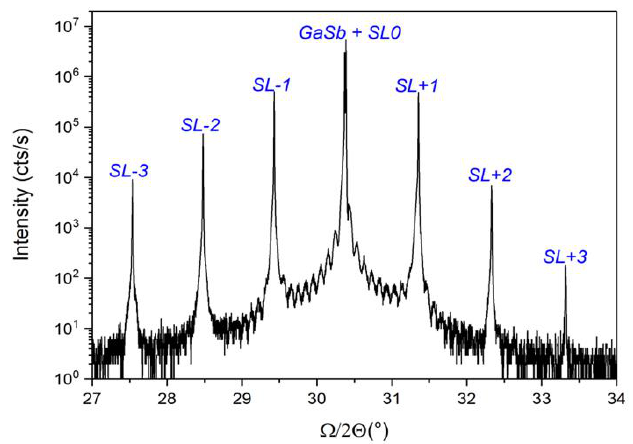
Figure 4. High-resolution x-ray diffraction HRXRD pattern of a p = 5.3 nm Ga-free InAs/InAs 0.655 Sb 0.345 T2SL structure grown on a GaSb substrate.